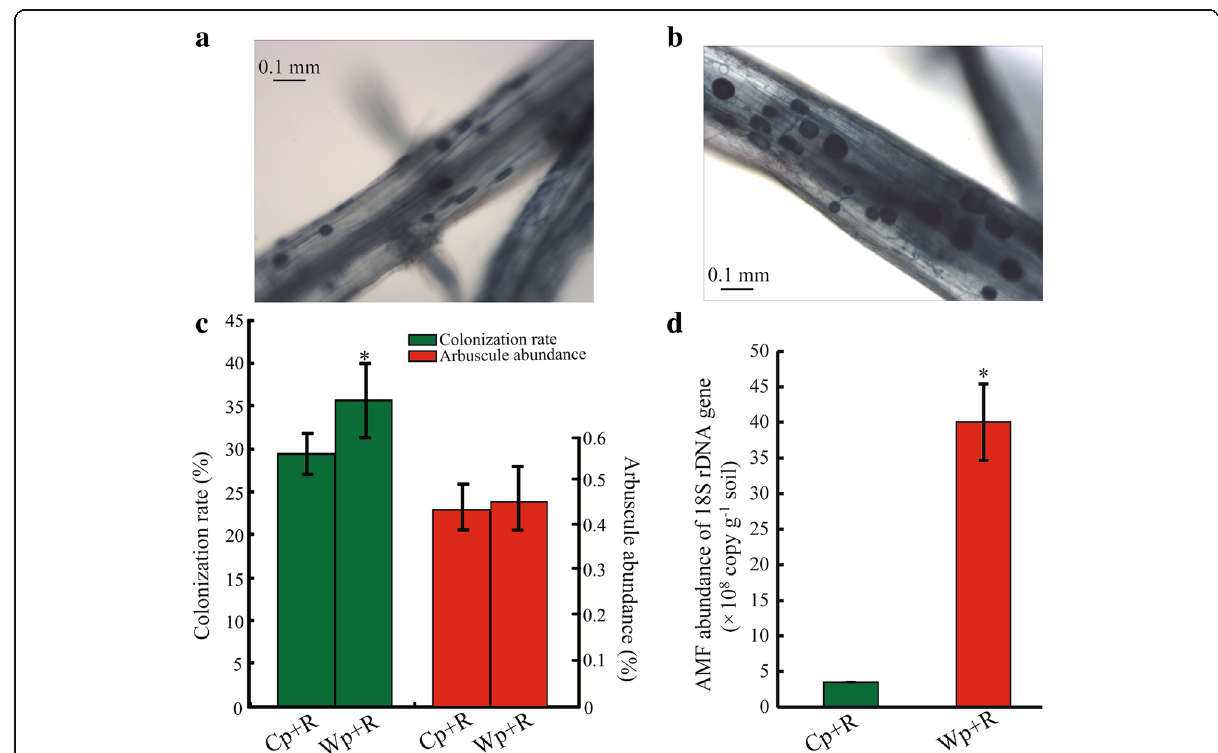
Fig. 2 a-b Microscopic observation of root colonization of ( a ) wild and ( b ) cultivated rice inoculated with the arbuscular mycorrhizal fungus Rhizoglomus intraradices . c-d Colonization rate and arbuscule abundance of R. intraradices in roots of inoculated rice plants ( c ) and abundance of R. intraradices ( d ) in the rhizosphere soil of rice plants following soil inoculation with R. intraradices and plant infection with Magnaporthe oryzae